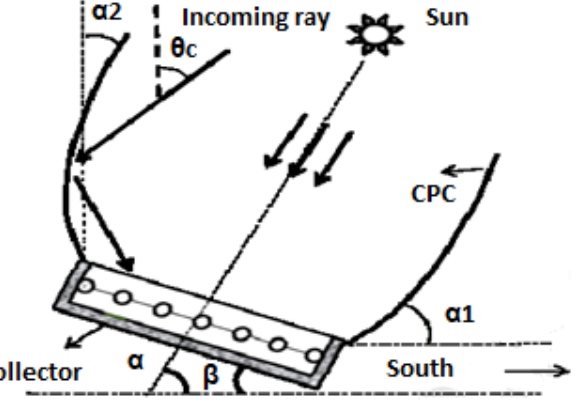
Figure 13. Diagram of the system studied by Al Imam et al. [41]. Adapted with permission from Elsevier.